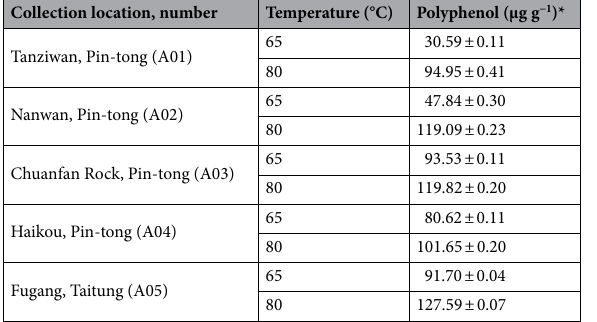
Collection location,